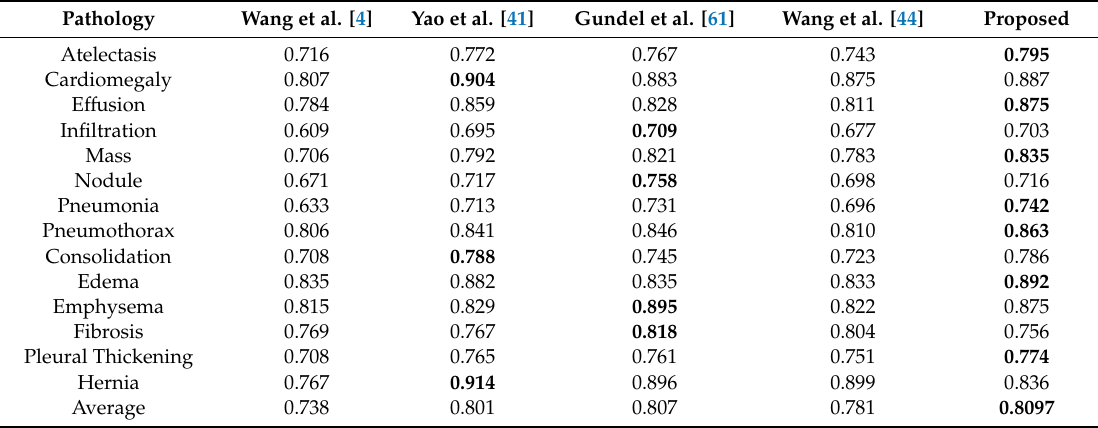
Table 3. AUC comparison of the 14 pathologies classification in the ChestX-ray14